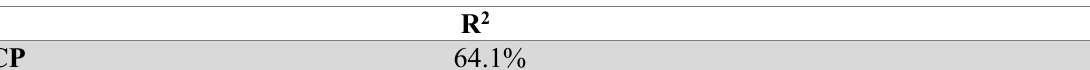
Expected Variance SCP